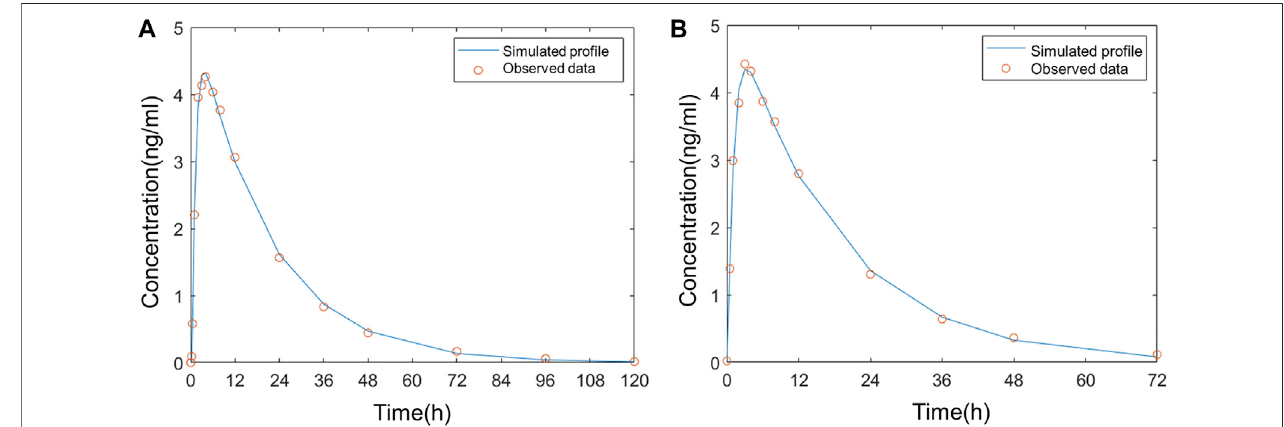
FIGURE 3 | Comparison of the observed plasma concentration – time curve following oral administration to the simulated (A) in Americans; (B) in Chinese.